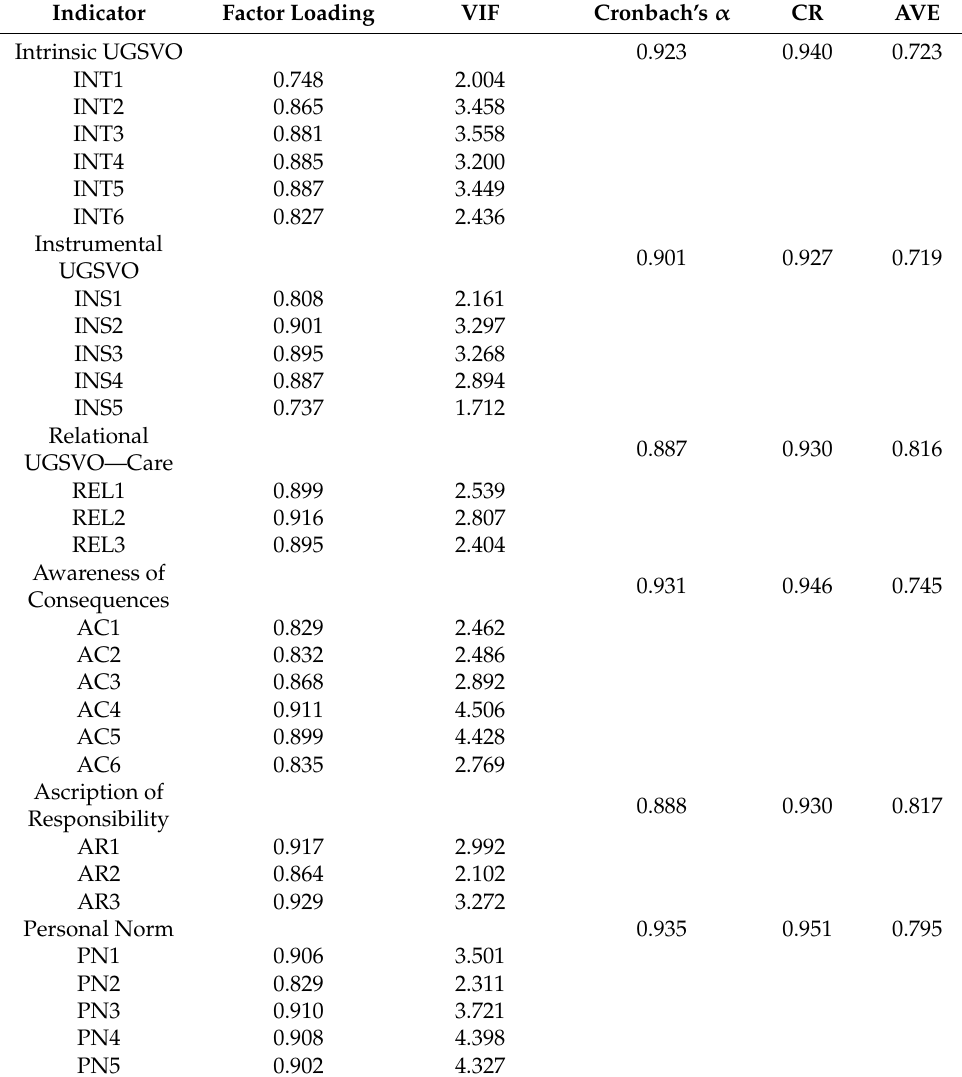
Table 3. Validity and reliability of latent constructs in the model.